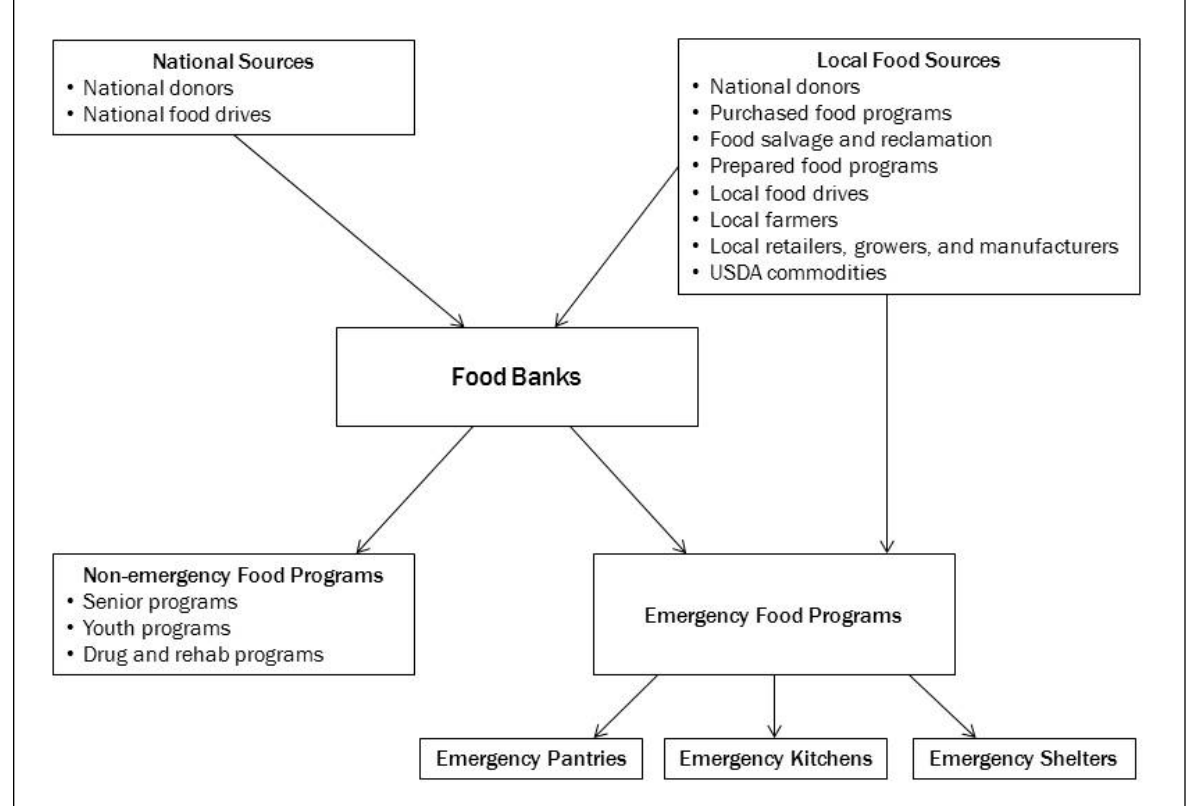
Figure 1. United States Emergency Food Network (adapted from Feeding America,